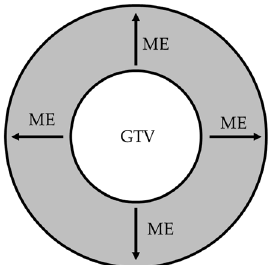
Figure 1. A schematic figure illustrating the GTV-to-CTV margin for ME into the lung parenchyma. GTV, gross tumor volume; CTV, clinical target volume; ME, microscopic extension.